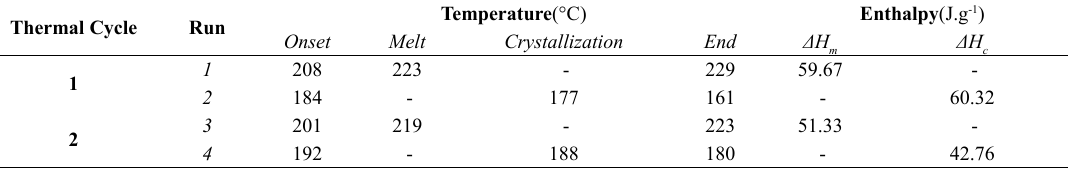
Table 2. DSC summary table.